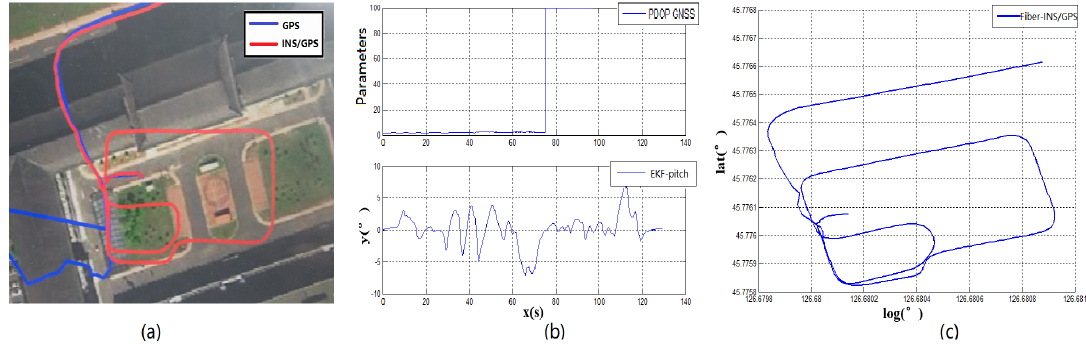
Figure 5. Experiment 1 test